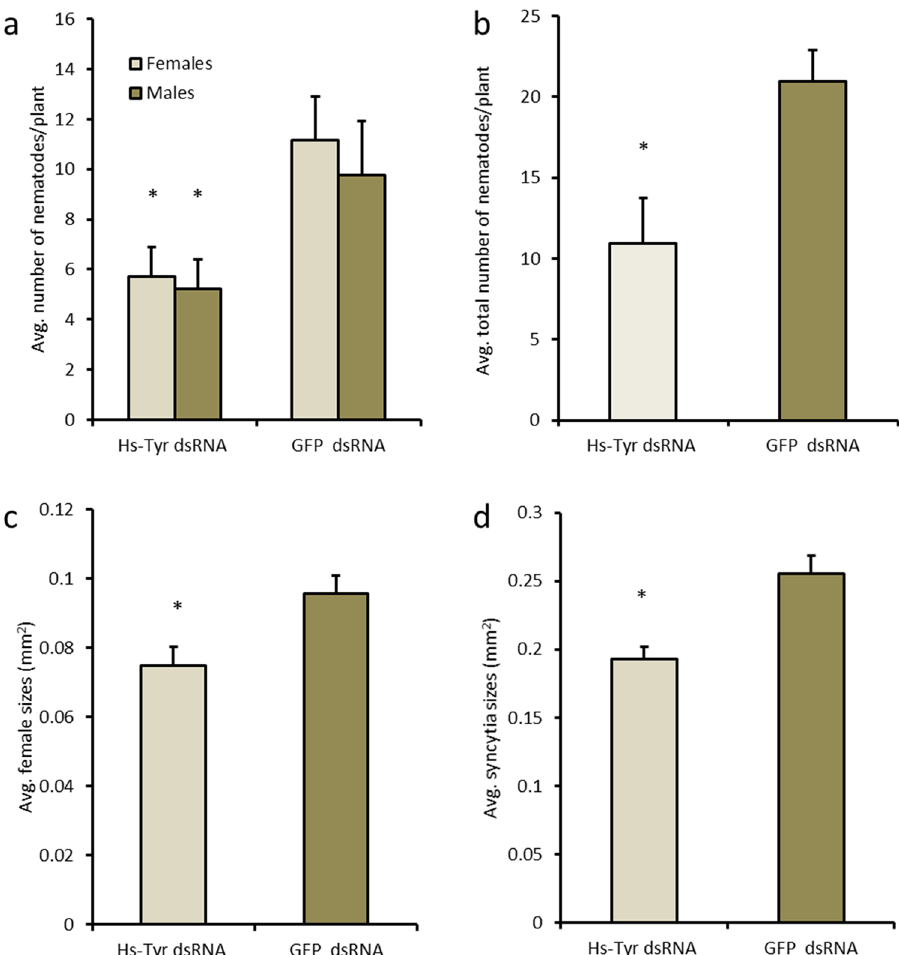
Figure 3. Effects of silencing Hs-Tyr on H. schachtii parasitism. The graphs show the results of bio-assays with J2 soaked in Hs-Tyr -specific dsRNA compared with J2 soaked in GFP dsRNA as a negative control. The following parameters were analysed: ( a ) number of males and females ( b ) total number of nematode infections ( c ) female size ( d ) size of syncytia. Data are based on three independent experiments. Each bar represents the mean ± standard error of n > 35. Asterisk indicate significant differences based on Student’s t-test ( P <